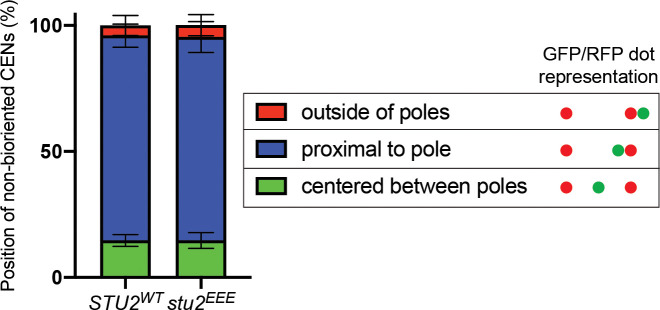
Examining the axial position of unseparated sister centromeres along the length of the mitotic spindle.Exponentially growing STU2-AID pMET-CDC20 cultures with an ectopically expressed STU2 allele (STU2WT, M2029; stu2EEE, M2030) and also containing SPC110-mCherry and CEN3 marked with GFP (CEN3::lacO LacI-GFP) were arrested in methionine- and auxin-containing medium for 2.5 hr and the axial position of unseparated sister centromeres along the length of the mitotic spindle (near spindle equator, proximal to one Spc110-mCherry foci, or outside of Spc110-mCherry foci) was determined. Schematic shows representative sister centromere positions illustrated as GFP/RFP dots. Graphs represent an average of three biological replicates, n = 50 cells each.